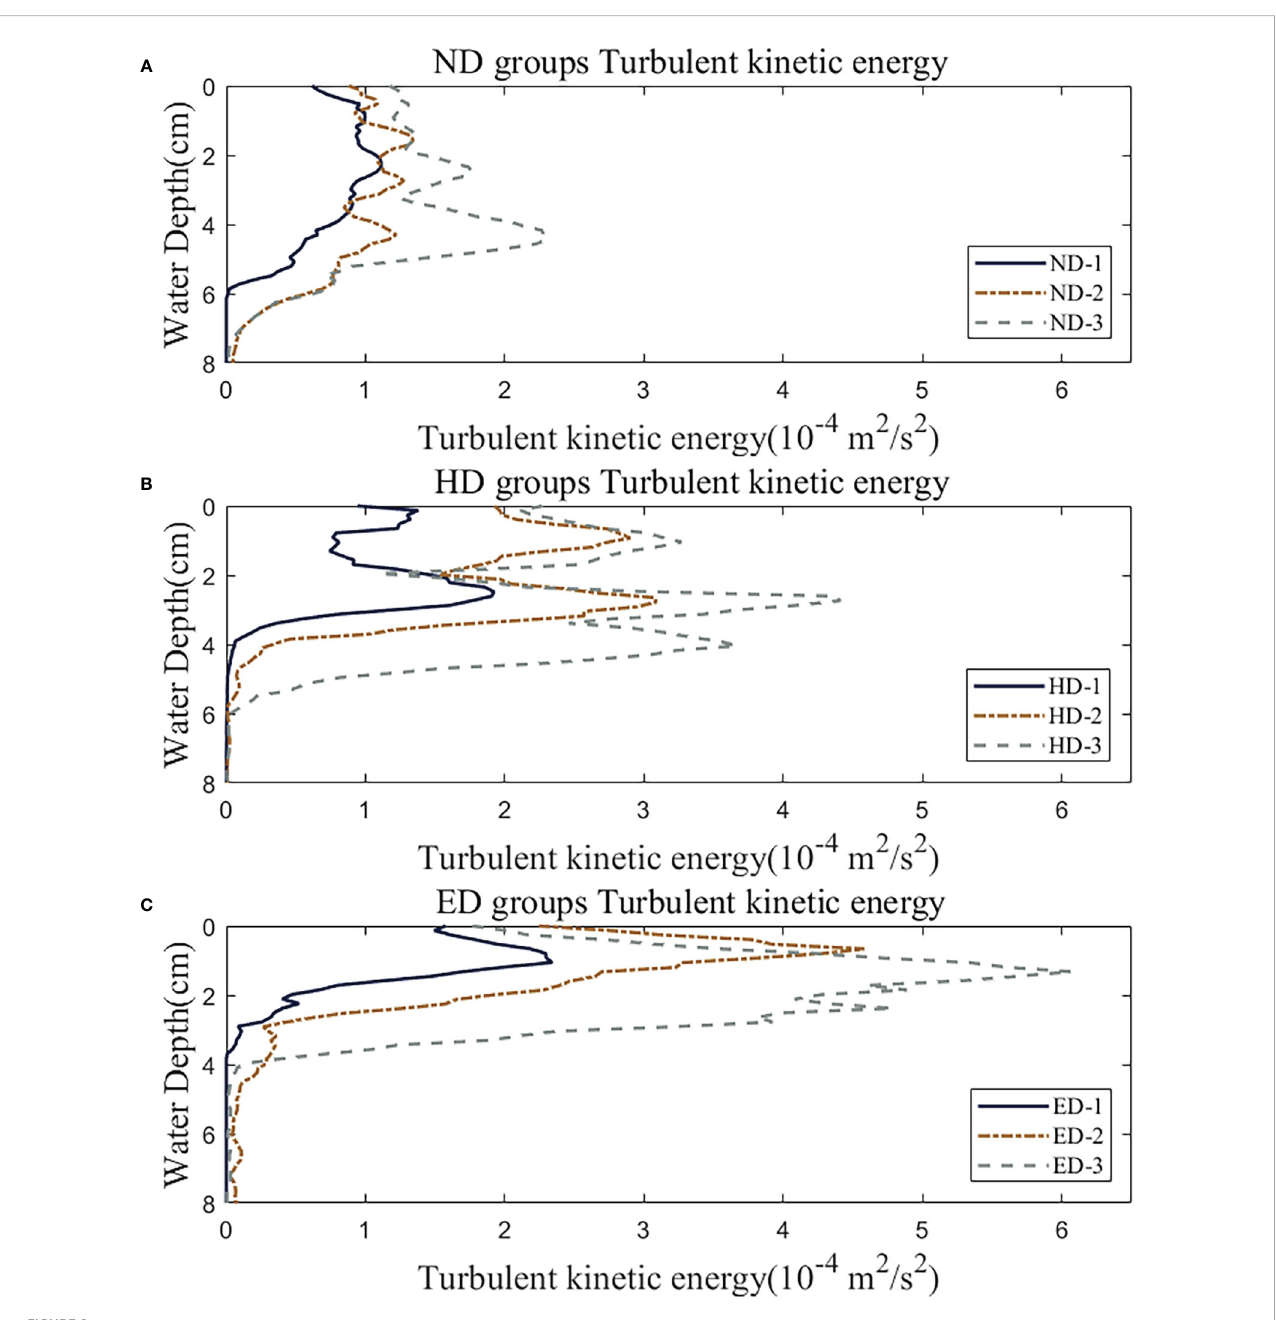
FIGURE 9 Turbulent kinetic energy at the maximum thickness section: ND group (A) , HD group (B) and ED group (C)